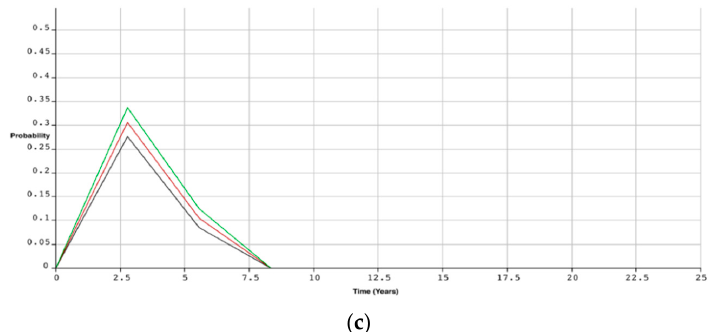
Figure 7. The performance of three mooring lines in a degraded state ( a ) line 1, ( b ) line 2, ( c ) line 3. Table 4. Expected number of repairs and associated